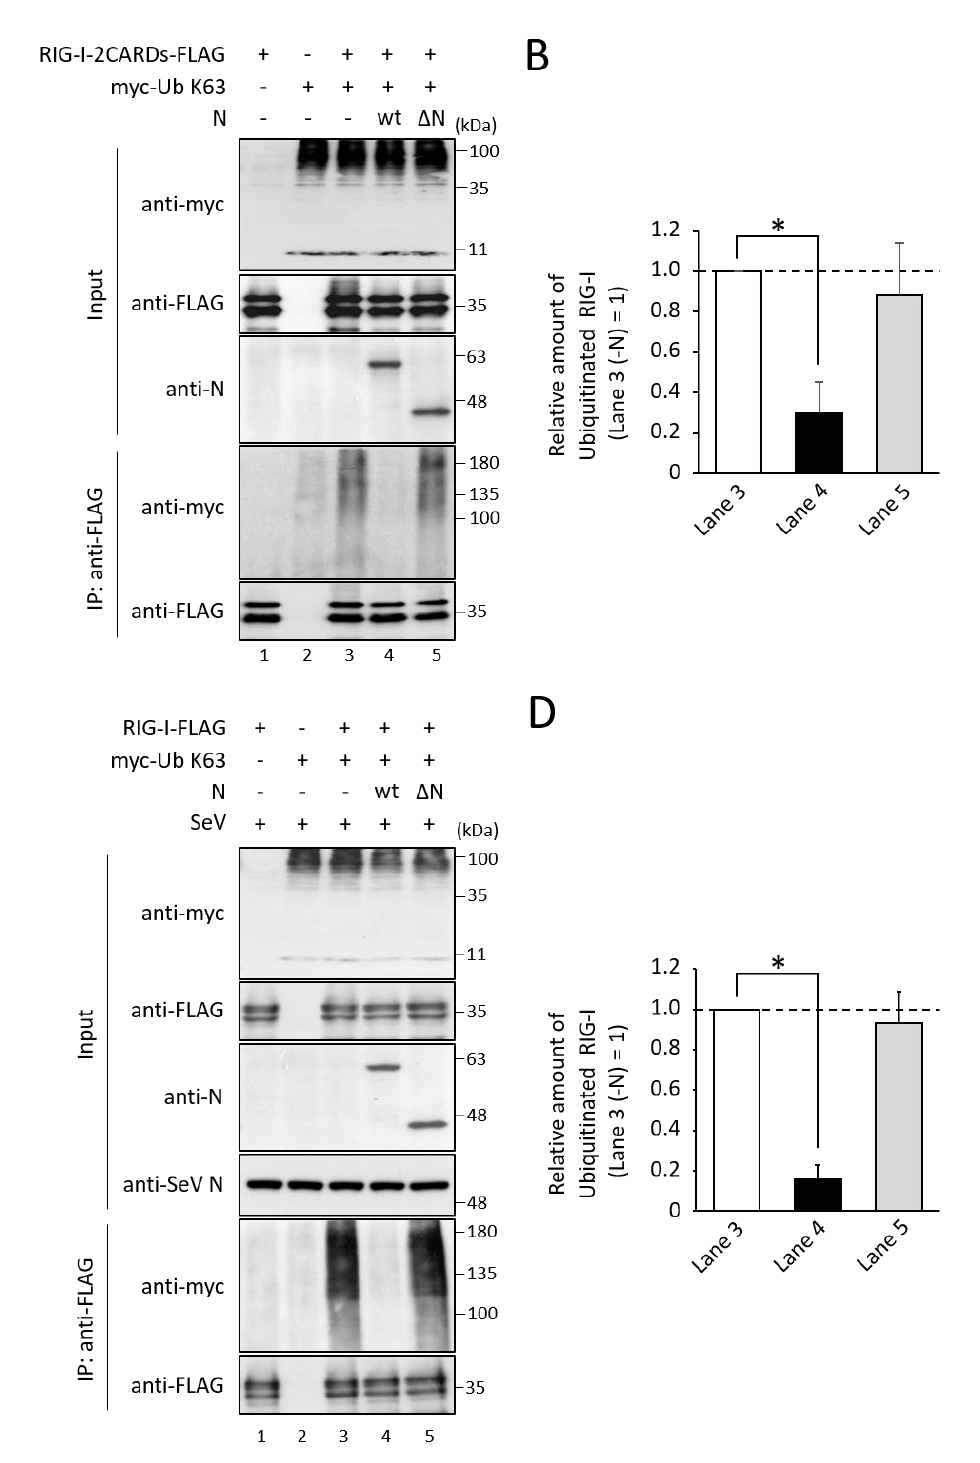
Figure 5. Effects of N protein on RIG-I ubiquitination. ( A , C ) RIG-I-2CARDs-FLAG ( A ) or full-length RIG-I (RIG-I-FLAG) ( C ), together with myc-Ub K63 and N protein was expressed in COS cells. After 24 h, cells were infected with SeV at an MOI of 10 for 24 h ( C ). Cell lysates were then analyzed by immunoblot and immunoprecipitation assays (Figure 2). ( B ) The quantitative densitometry of ubiquitinated RIG-I in ( A , C ) was performed as described in Figure 4B, and was shown in ( B ) and ( D ), respectively. Data are the means from three independent experiments, and are shown as the relative value (lane 3 ( A ) or lane 8 ( C ) = 1). p values were calculated by the Student’s t test. *, p < 0.05, compared to values of lane 3. Error bars indicate standard deviations.